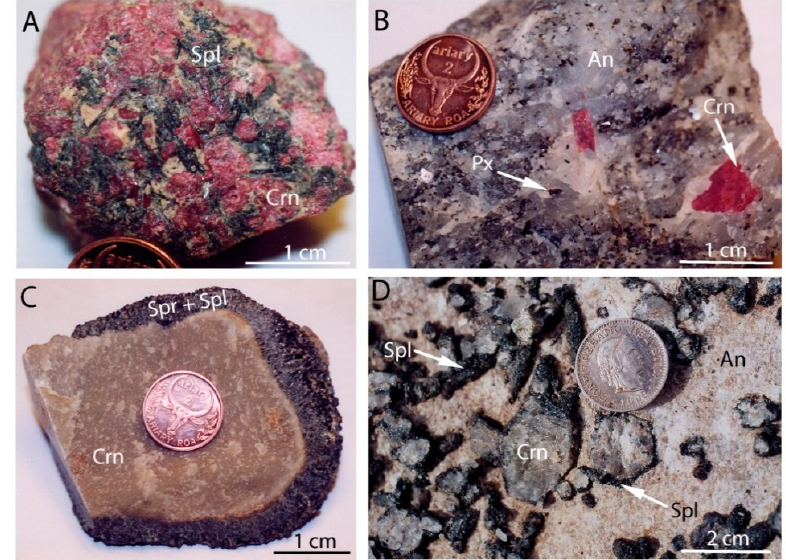
Figure 42. The sakenites from Sakeny and other sites in Southern Madagascar. ( A ) Corundumite composed of ruby (Crn) and spinel (Spl). Collection Lacroix, MNHN, Muséum National d'Histoire Naturelle de Paris; ( B ) sakenite, i.e., plumasite from the Anavoha occurrence. The ruby crystals are disseminated in a matrix of anorthite (An) and pyroxene (Px). Collection Lacroix, MNHN Paris; ( C ) the corundumite from Sakeny. A corona of sapphirine (Spr) and spinel is present around the whitish sapphire (Crn). Collection Lacroix, MNHN Paris; ( D ) sakenite vein with anorthite, corundum + spinel at Bekinana (Tranomaro area). The corundum generally shows a corona of black spinel. Photos: Gaston Giuliani.